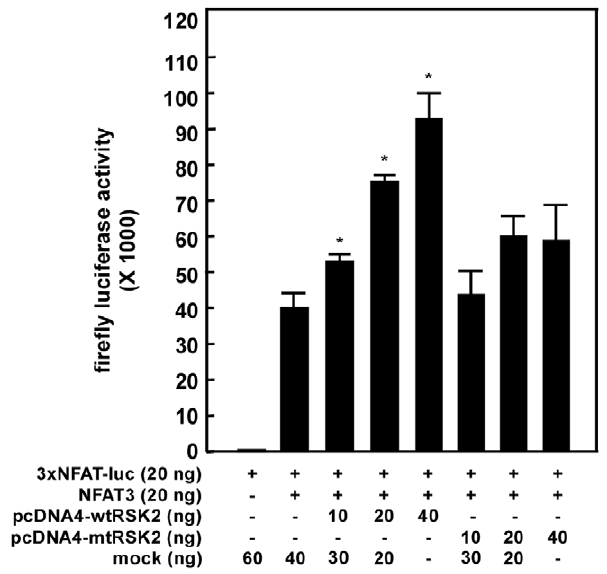
Figure 8. Mutation of Lys216 results in inhibition of full length RSK2 activity exvivo . Wildtype RSK2 induced NFAT3 activity in a dose-dependent manner. K216A mutant showed reduced activity. The 3 6 NFAT-luciferase reporter plasmid was co-transfected with pcDNA3- Flag-NFAT3, pcDNA4-RSK2, or pcDNA4-RSK2-K216A plasmids into HEK 293 cells. The firefly luciferase activity was analyzed after 36 h and normalized against Renilla luciferase activity. Data are presented as the mean 6 S.D. of values from triplicate experiments. The differences were evaluated using the Student’s t-test (*, p , 0.05). The equivalent level of each expressed protein was confirmed by Western blot and shown in Figure S3.